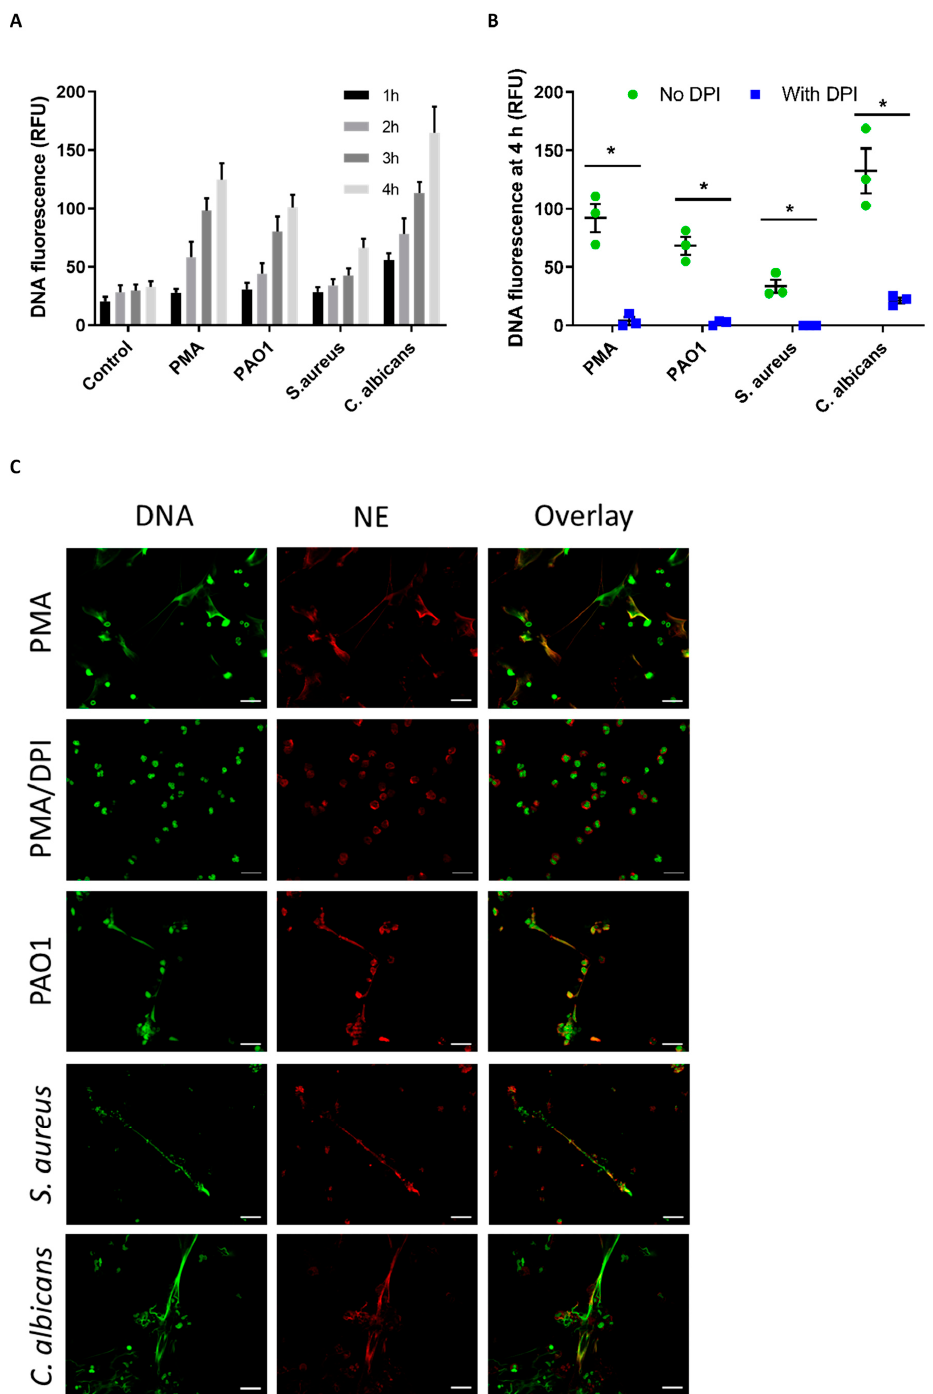
Figure 1. Time course and NADPH oxidase-dependence of NET formation with each stimulant. ( A ) Increase in DNA fluorescence over time when neutrophils were incubated either alone (Control) or with PMA (20 nM), P. aeruginosa PAO1 (MOI 10), S. aureus (MOI 10) or C. albicans (MOI 2). Data are means (SE) of three separate experiments. ( B ) Neutrophils were incubated with the same stimulants as in ( A ) in the presence or absence of the NADPH oxidase inhibitor DPI (10 µ M) and DNA fluorescence was measured after 4 h. The fluorescence of control cells was subtracted from that of stimulated cells. Data are means (SE) of three separate experiments. *, significantly different than without DPI ( p < 0.05 by paired t -test); ( C ) confirmation of NETs by immunofluorescence. Neutrophils were stimulated for 4 h in the presence or absence of DPI. Samples were then fixed and stained to show co-localization of DNA (green) with neutrophil elastase (NE) (red). Images are representative of at least three separate experiments. Scale bars represent 20 µ